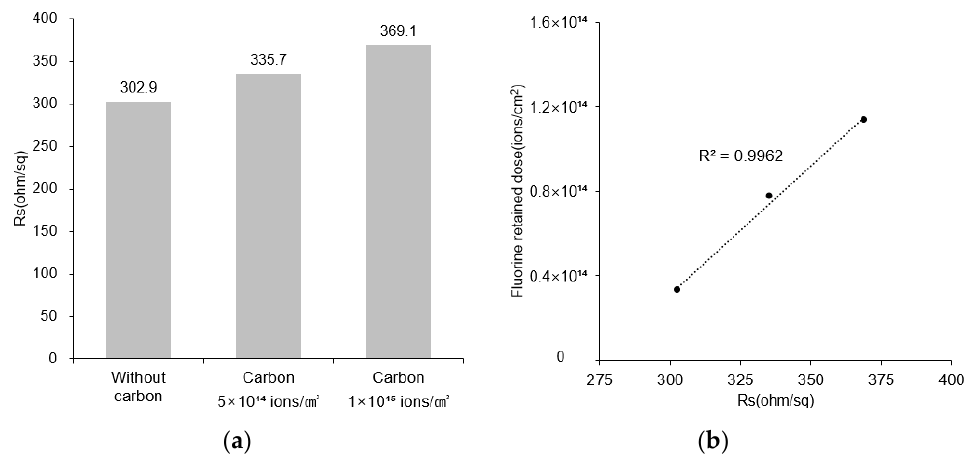
Figure 6. ( a ) Measurement results of sheet resistance. ( b ) Correlation between sheet resistance and the retained dose of fluorine.